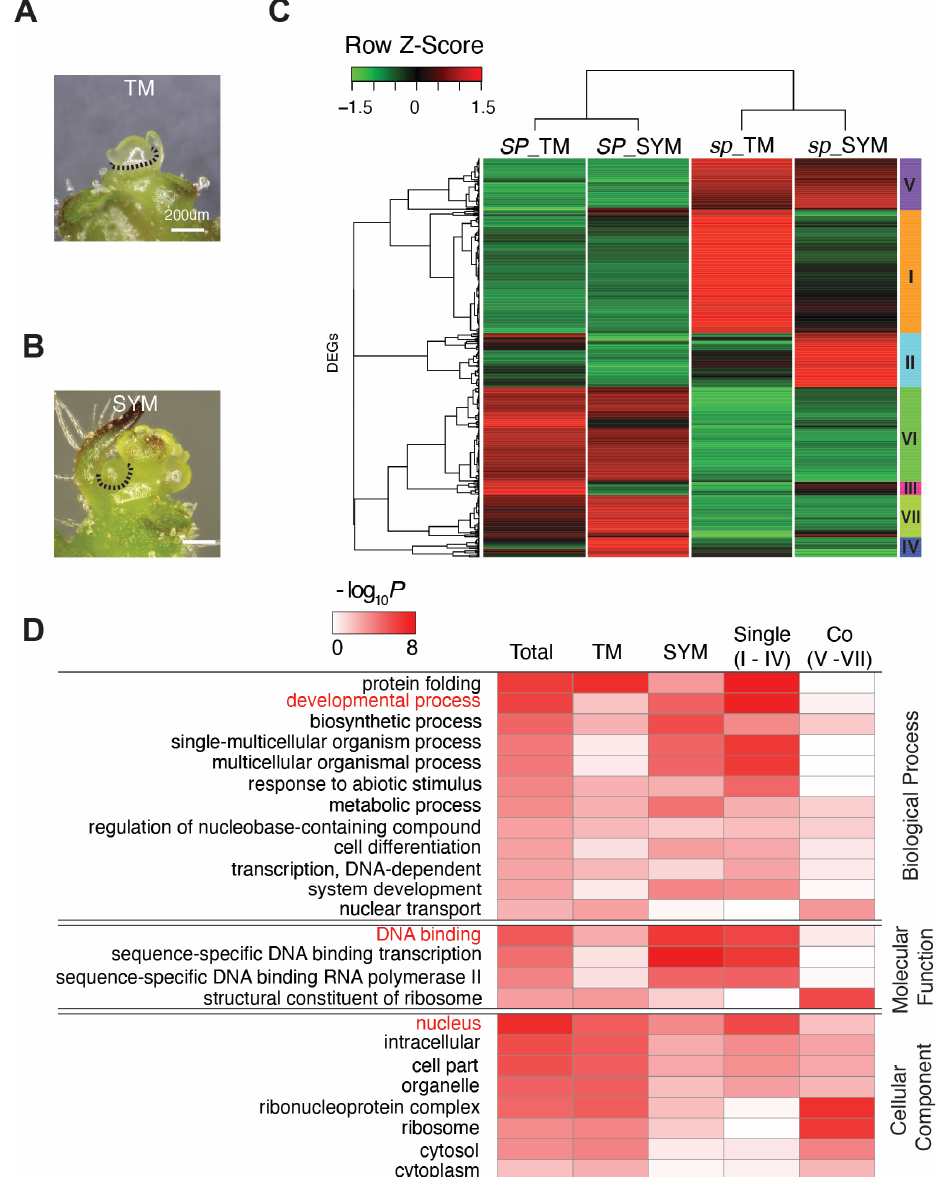
Figure 6. Hierarchical clustering analysis and GO term enrichment assay using DEGs between SP and sp -classic. ( A , B ) Microdissection of the TM stage ( A ) and SYM stage ( B ) was used for RNA extraction [24]. Dashed lines indicate dissected tissue lines. ( C ) Hierarchical clustering of DEGs at the TM and SYM stages between SP and sp-classic . Clustering is visualized by heatmap, and seven clusters (I–VII) are grouped based on the dendrogram. The FPKM expressions are normalized to row-wise Z-Scores. ( D ) Enrichment of gene ontology functional analysis of DEGs. -Scaled -log 10( p values) are shown in the heat map (Table S7). ‘Single’ indicate DEGs showing differential expression in only one meristem stage. ‘Co’ indicate DEGs on both meristem stage. Red fonts indicate the major terms in functional analysis of ‘Single’ DEGs group.